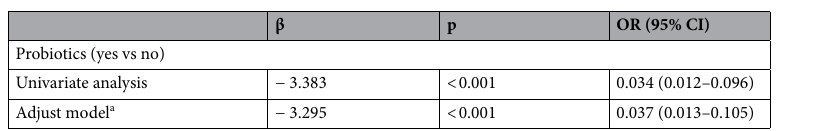
Table 3. Univariate and multivariate logistic regression analyses for the association between probiotics and BPD/death. a Adjusted for baseline maternal diabetes, the proportion of systemic antibiotics given to mother within 24 h before birth, the receiving rate of invasive mechanical ventilation, the prevalence of PDA, RDS and